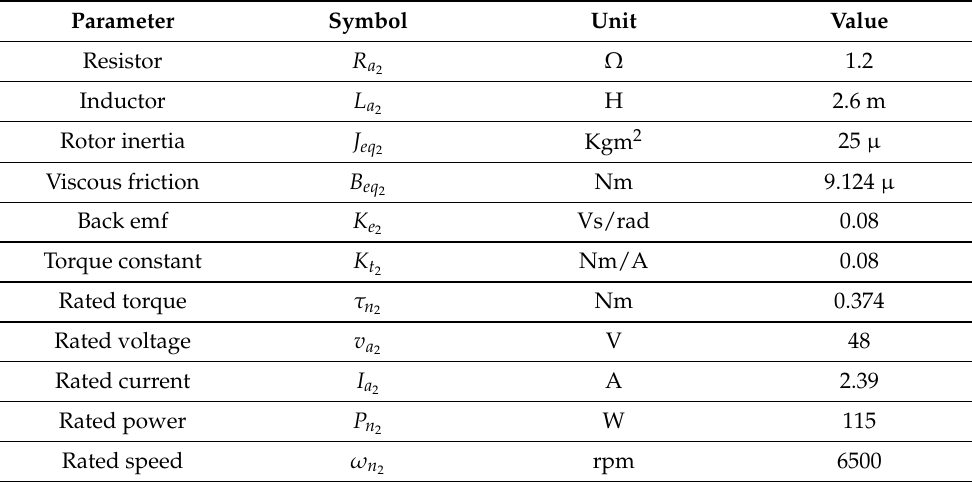
Table 3. Data ME2130-198B